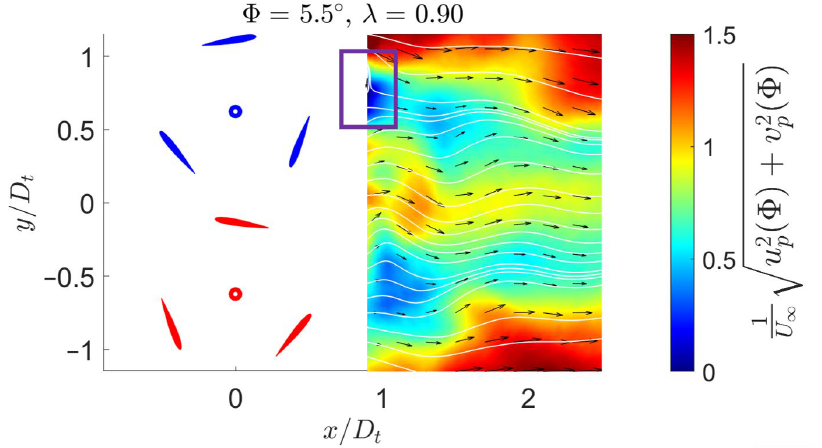
Figure 10. A zoomed in picture of Figure 9e. The re-circulation zone behind turbine T2 is enclosed in the purple solid lines.